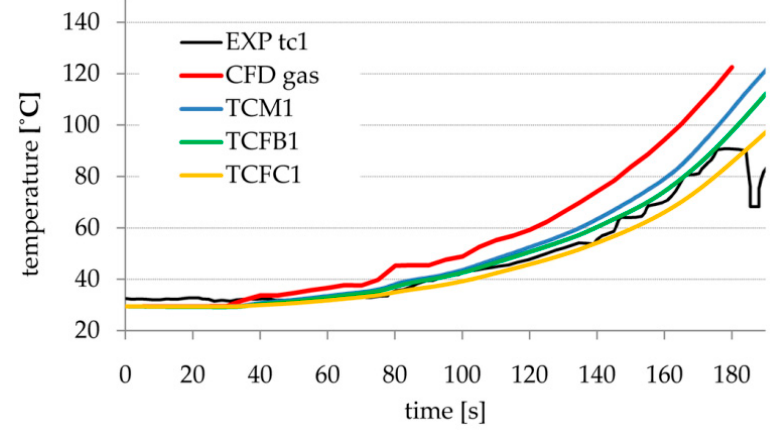
Figure 11. Calculated and measured temperatures for thermocouple TC1.